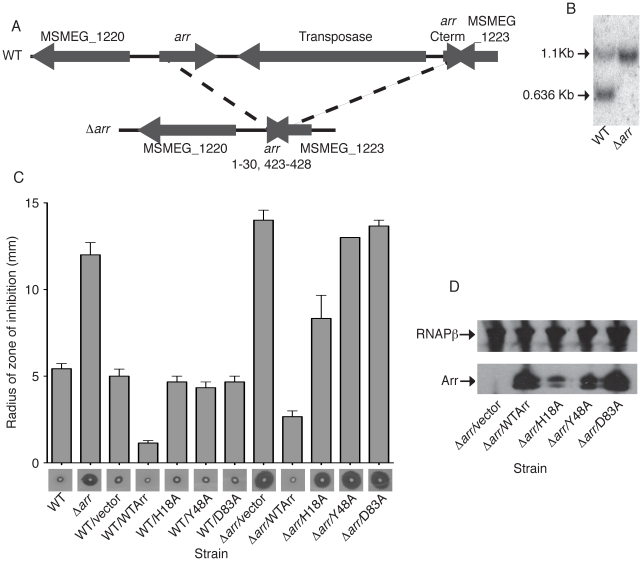
Arr requires substrate binding and catalytic activity to confer rifampin resistance in M. smegmatis.A. Schematic of the region of the M. smegmatis chromosome containing arr that was deleted via allelic exchange (nucleotides 1290611 to 1293058). The wild-type arr gene was replaced with a truncated null allele (Δarr) containing only the first 10 and last 2 codons, thus yielding the M. smegmatis Δarr strain. B. Southern blot analysis of wild-type M. smegmatis and Δarr using PvuI digested genomic DNA and a probe that spans the 800 nucleotides upstream of the arr gene. PvuI digestion of wild-type M. smegmatis yields two bands of 1085 and 636 base pairs. PvuI digestion of Δarr results in a 1085 bp and a 1067 bp band, which are indistinguishable on the southern blot. C. Wild-type M. smegmatis or Δarr strains expressing wild-type FLAG-Arr, FLAG-tagged Arr point mutants, or containing an empty expression vector (vector) were plated as a lawn on LB. Disks soaked with 5 µl of a 25 mg/ml rifampin stock in DMSO were placed in the center of each lawn. Following two days of growth at 37°C, the radius of the zone of inhibition was measured. Graph shows the mean radius from three experiments. Photos of the zone of inhibition from a representative experiment are also shown for each strain. Disks soaked in DMSO with no drug produced no zone of inhibition (data not shown). D. Western blot of whole cell lysates with antibodies specific for the FLAG epitope tag or RNAPβ (loading control) from Δarr cultures expressing FLAG-tagged Arr or FLAG-tagged Arr point mutants.